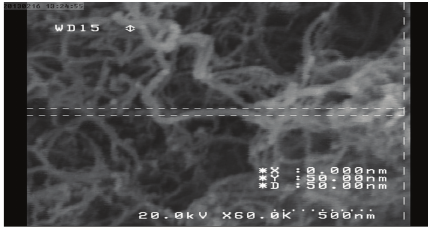
Figure 1: FE-SEM image of the obtained bundles MWCNTs shows a maximum length of 10 𝜇 m and diameters of around 50nm.